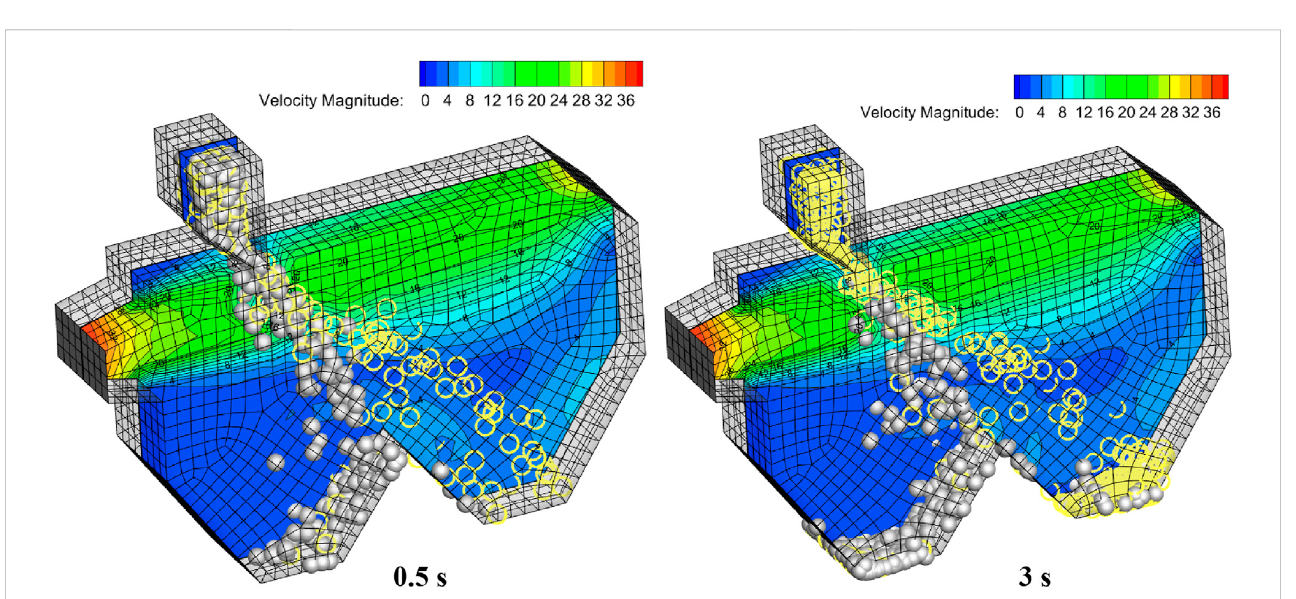
FIGURE 8 Material particles position transient